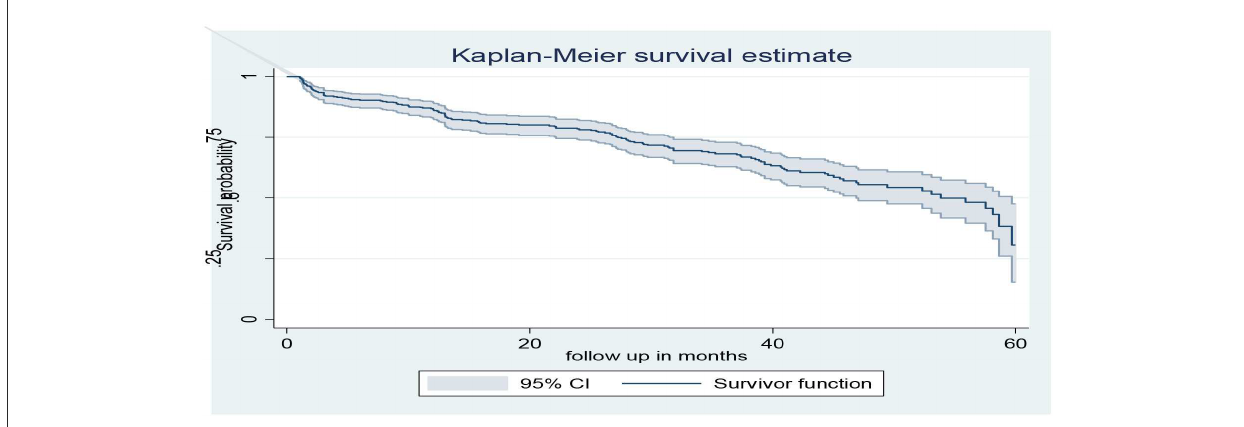
FIGURE1 The overall Kaplan–Meier survival curve of HGEs-free survival estimate of adult patients with diabetes in Bahir Dar public hospitals, North West Ethiopia, 2021 ( n = 453).